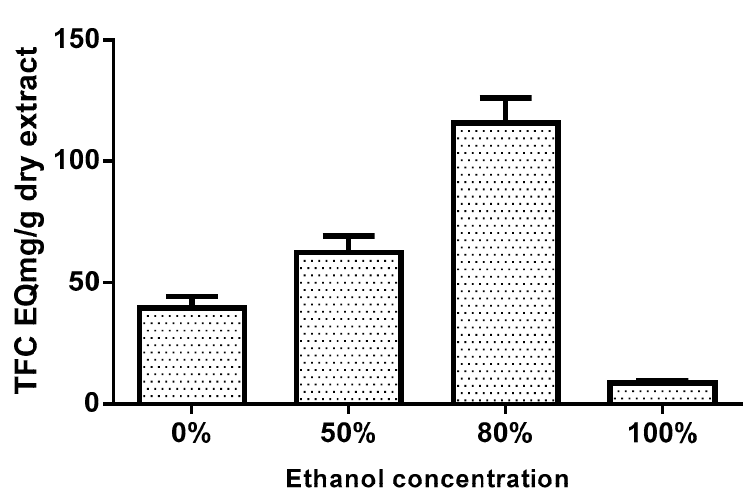
Figure 1. Comparison of total flavonoids content in ethanolic extracts. Samples of Bougainvillea x buttiana extract ethanol 0%, 50%, 80%, and 100% at 26 ◦ C for 24 h were assayed to determine the concentration of total phenolic content as described in Materials and Methods. Each bar corresponds to the results (mean ± standard deviation (SD)) from three di ff erent preparations.